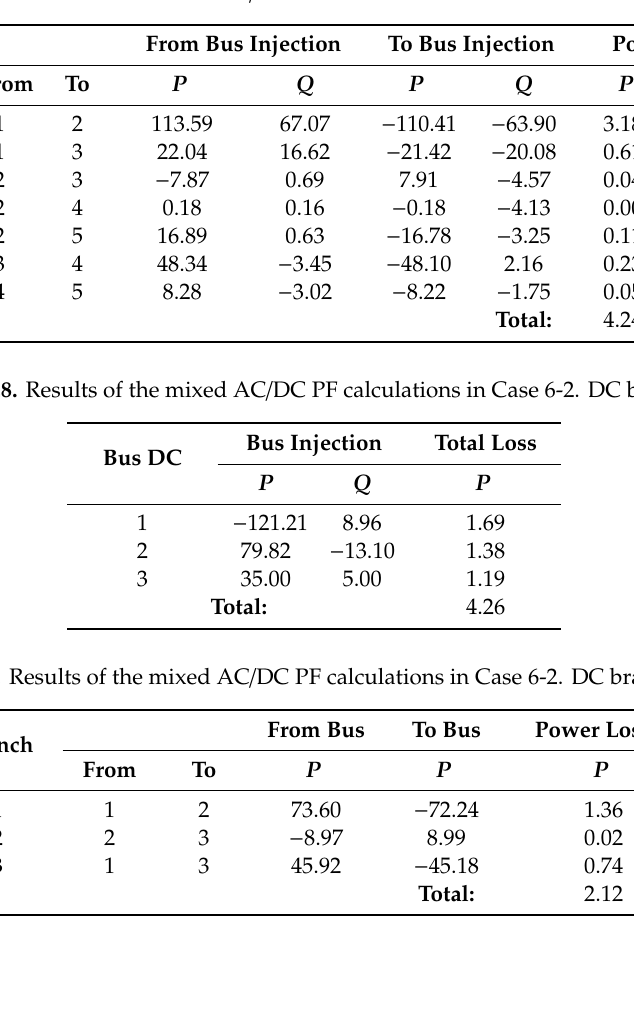
Table A27. Results of the mixed AC / DC PF calculations in Case 6-2. AC branch data.